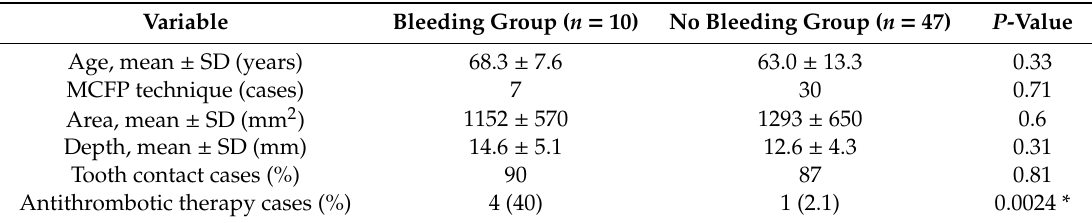
Table 2. Postoperative bleeding.